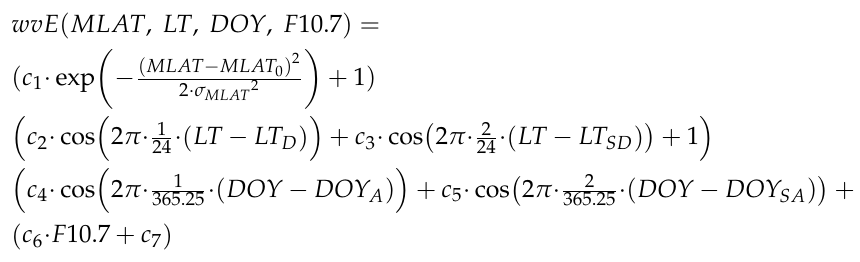
Table 4. Coefficients of the E layer vertical profile width (wvE) model for the Northern and Southern Hemispheres. wvE Model Coefficients